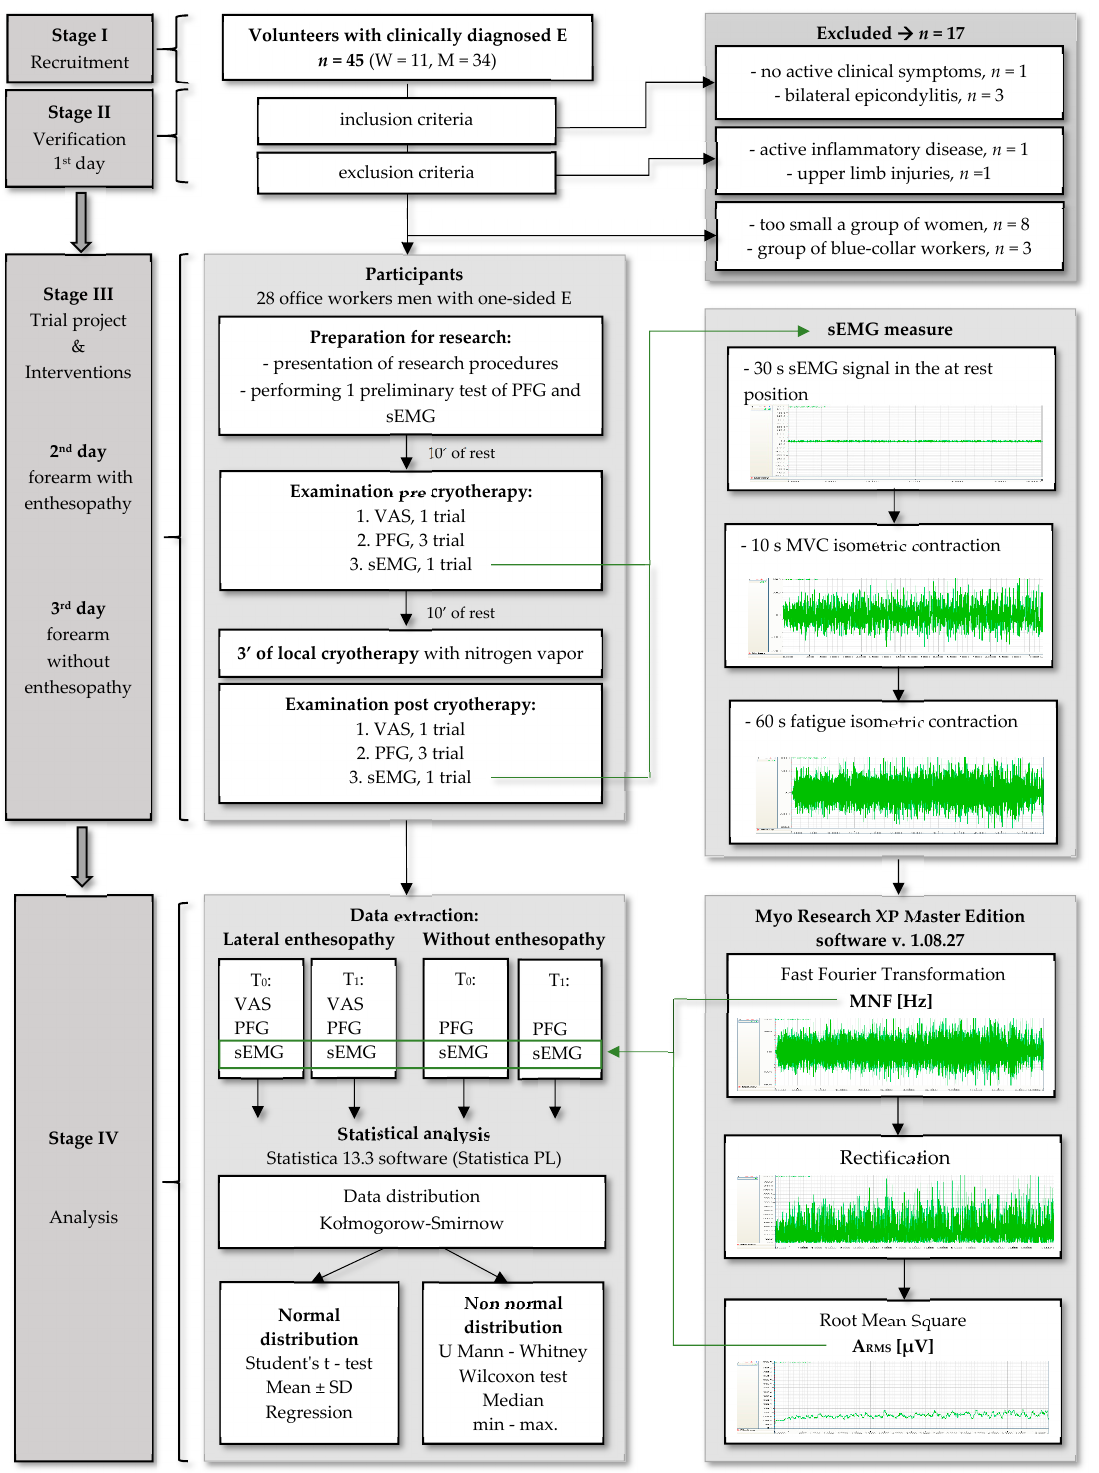
Figure 1. The flow chart presenting the developed research process. Subjects with systemic inflammatory disease, fibromyalgia syndrome, cervical radicu- lopathy, peripheral neuropathy in the upper extremity, identified neurological and myo- genic diseases, history of upper limb injuries and hospitalisation in the last 6 months due to infectious diseases were excluded. Only 11 women entered the study, 8 of whom met the inclusion criteria and entered the study group. The group of women turned out